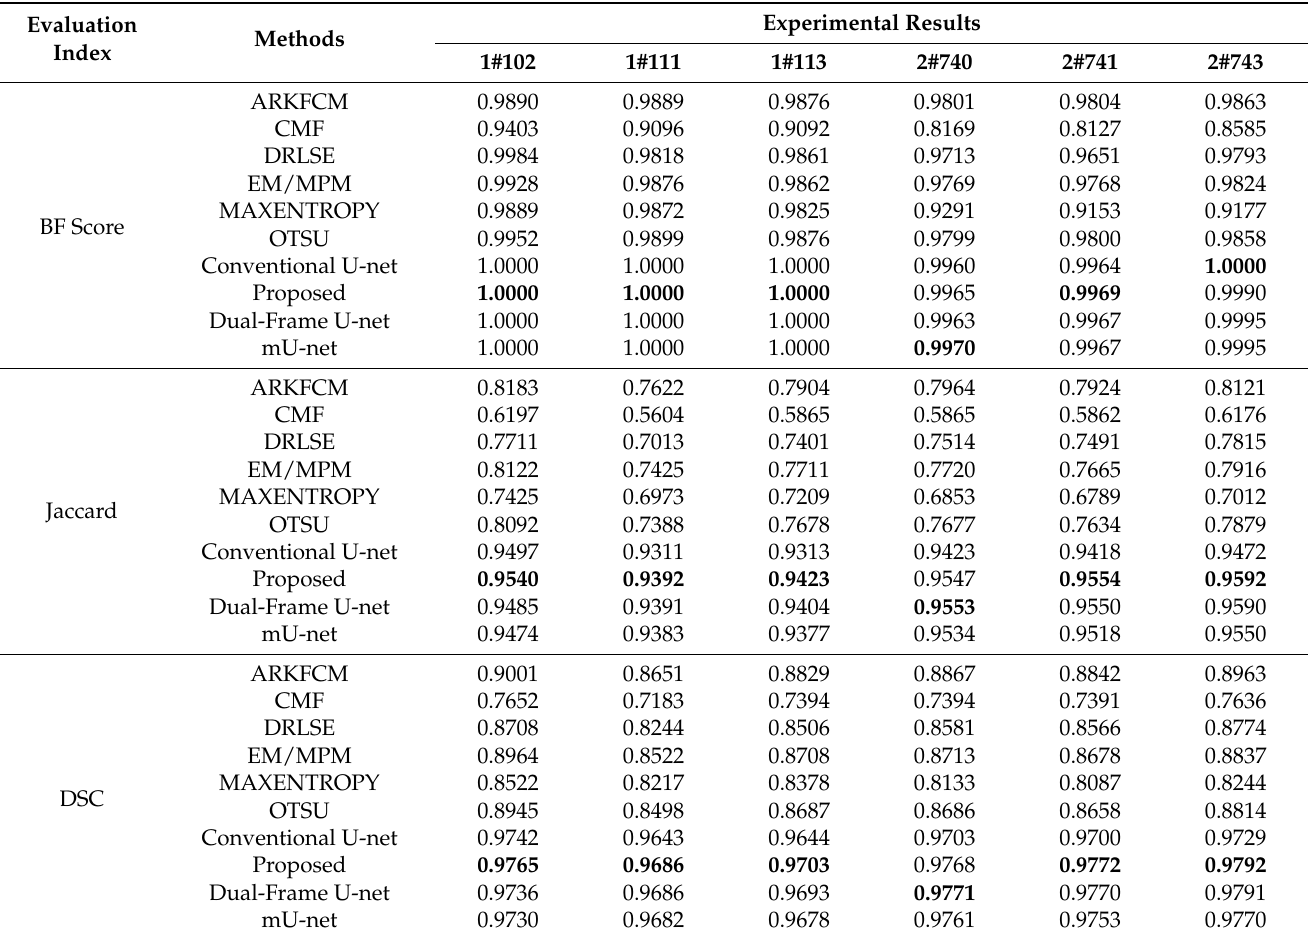
Table 2. Performance of the proposed approach and the comparison